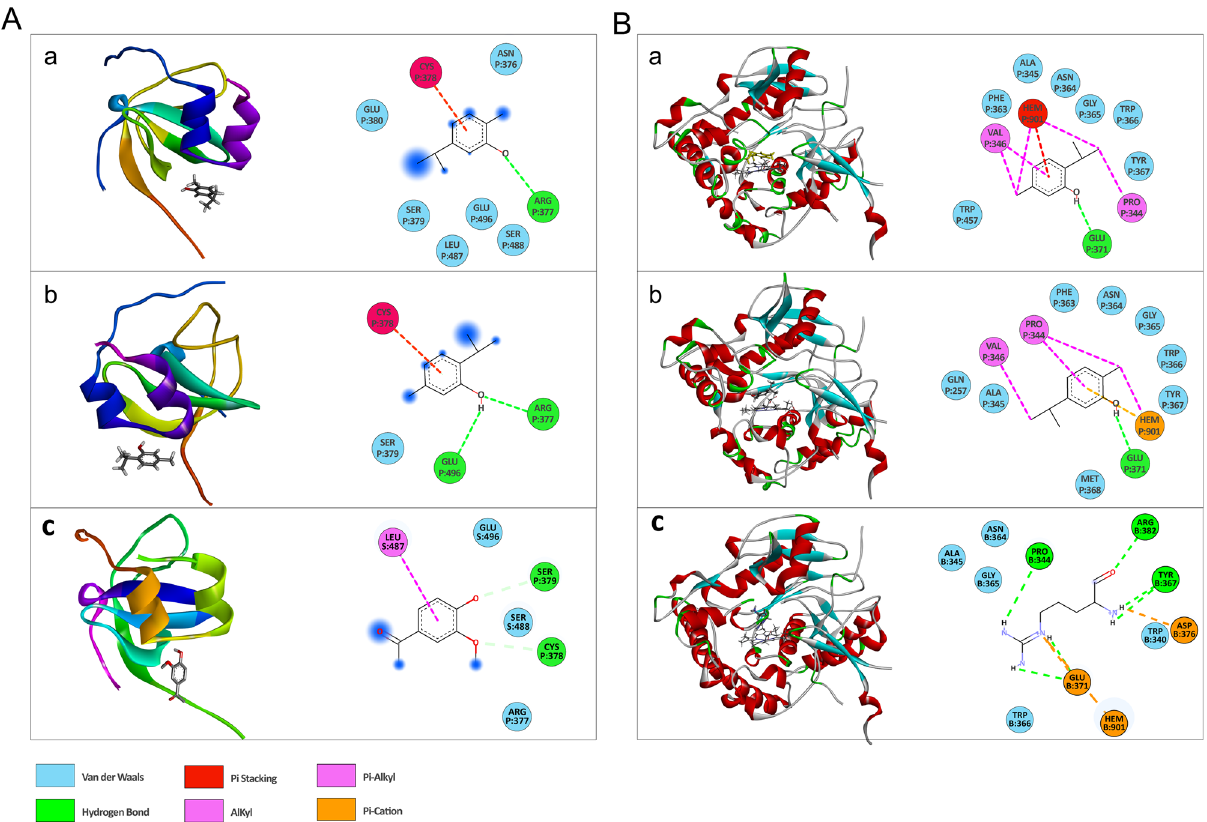
Figure 3. The interactions ( A ) between NOX (PDB ID:1K4U) and carvacrol (a), thymol (b), apocynin (c) ( B ) between iNOS (PDB ID:1nod) and carvacrol (a), thymol (b), and l-Arg (c). Conventional hydrogen bonds have been labeled using green dashed